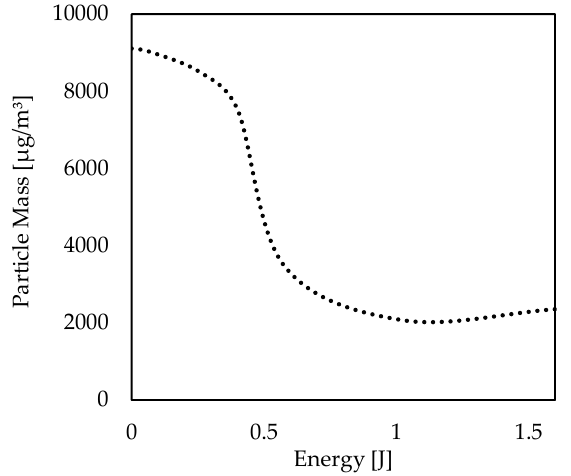
Figure 10. The conversion of Energy to effect PM reduction.